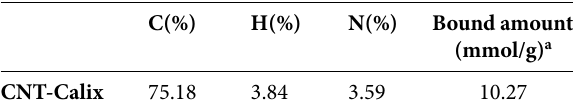
table 1. Elemental analysis results of CNT-Calix